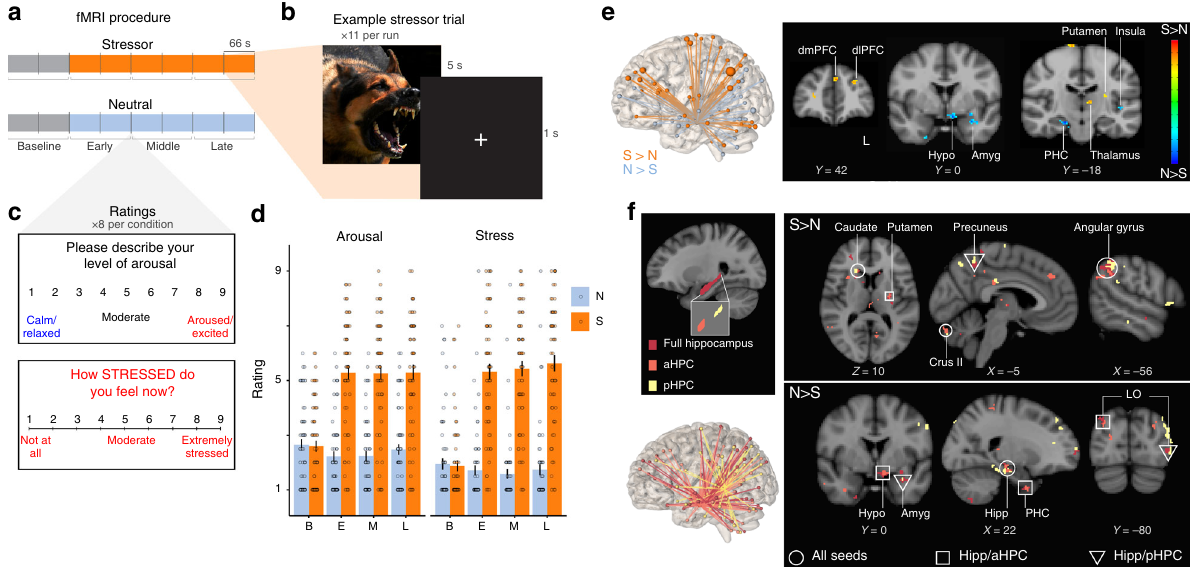
Fig. 1 Stressor exposure in fl uences feelings of stress and hippocampal connectivity. a Design. Functional neuroimaging data (fMRI) were acquired as participants were exposed to 6 consecutive runs of neutral/relaxing (Neutral condition, N) or highly aversive images (Stressor, S) immediately preceded by fi xation (Baseline, two runs). For analysis, these runs were aggregated into three two-run epochs (132 s each: Baseline, Early, Mid, Late), with mean connectivity and mean ratings computed within each of these windows. b In each condition, images (5 s) alternated with interstimulus intervals (1 s) during six 66-s runs. Photo shown is similar to those used in the experiment. c Ratings of feelings of stress were collected after each run on nine-point visual analog scales. Arousal levels were visualized using the Self-Assessment Manikin (not shown) 40 . d The stressor condition led to signi fi cant sustained increases in ratings of arousal and stress. B = baseline, E = early, M = Middle, L = late (as in a ). Overlaid dots represent individual participants. Bars show mean values per epoch and condition across participants; error bars = + 1SE. N = 60 participants. Source data are provided as a Source Data fi le. e Whole- brain hippocampal connectivity network signi fi cantly modulated by stressor exposure. Left, network overview, with node size re fl ecting number of voxels per identi fi ed cluster. Right, example slices from network. f Stressor-modulated connectivity networks from full, anterior, and posterior hippocampal